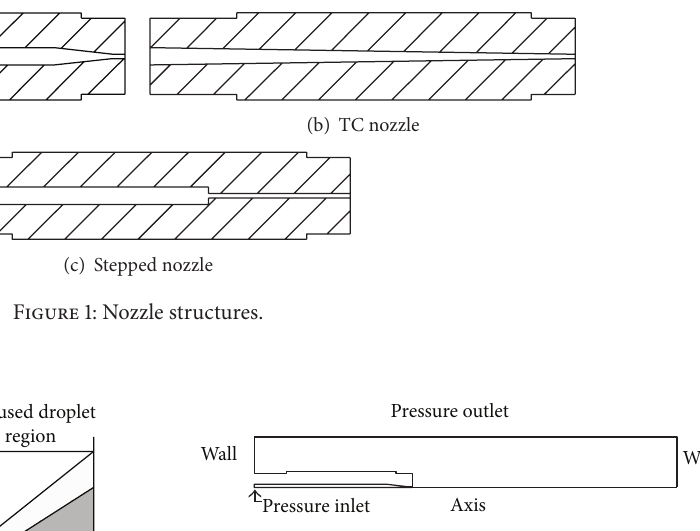
Figure 3: Computational area and boundary conditions of CC nozzle in